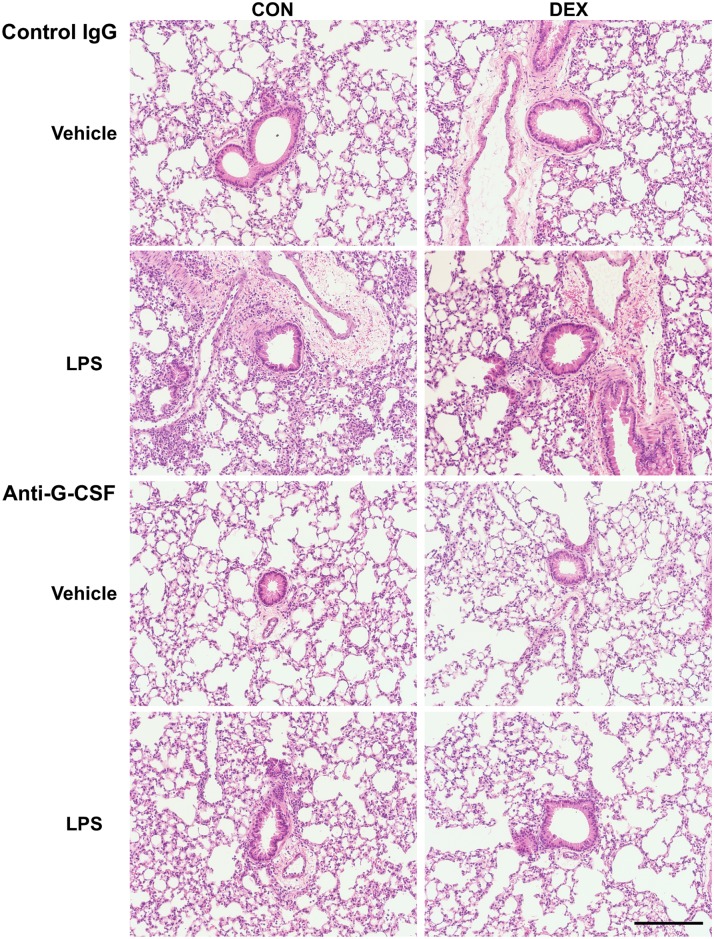
Representative histology of lung sections from different treatment groups.Scale bar, 2 mm.